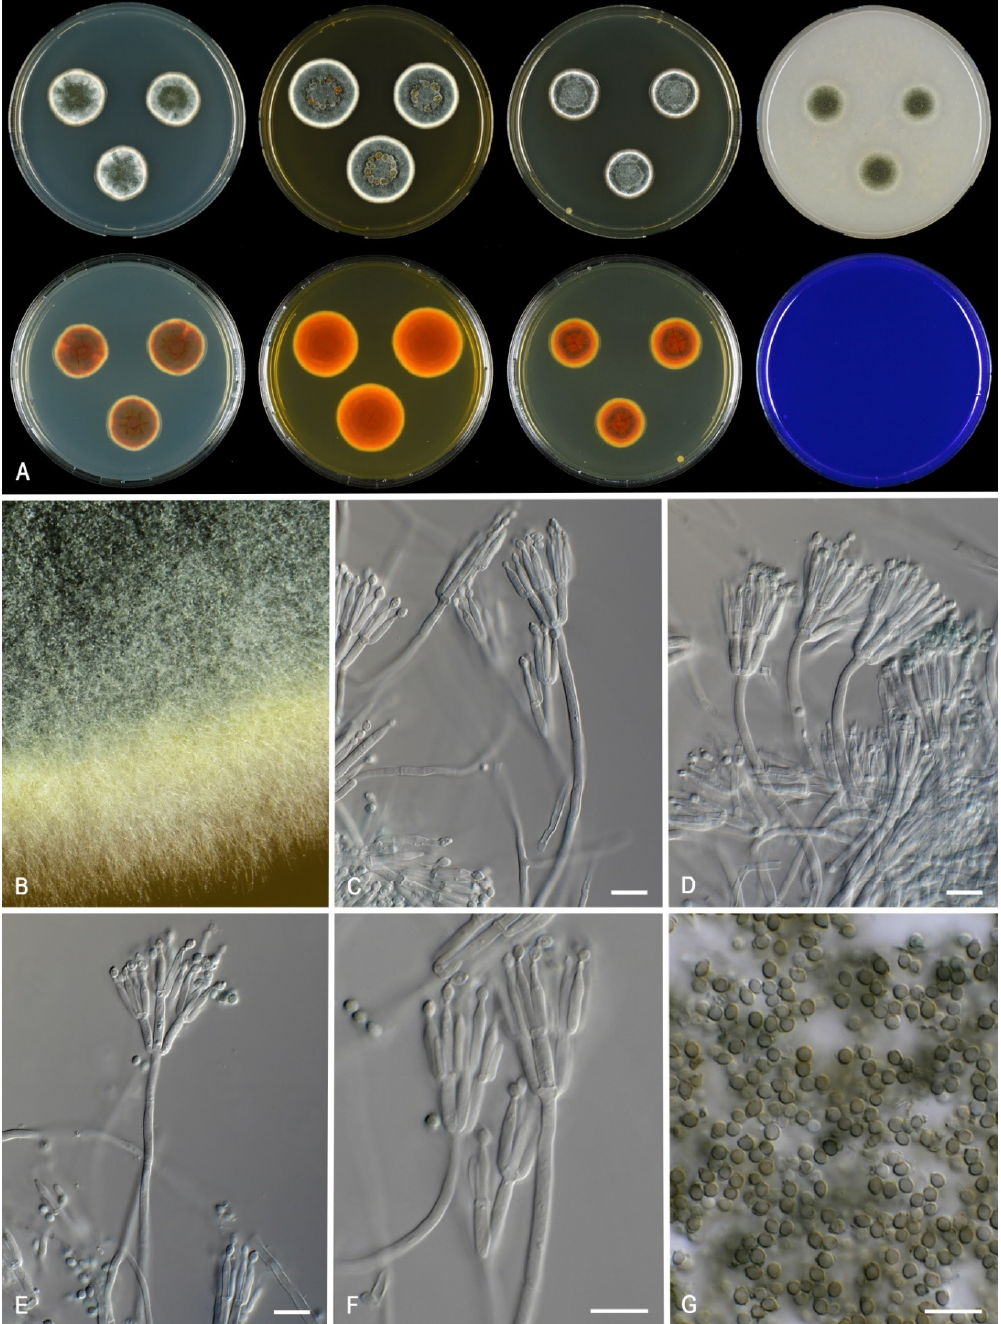
Figure 5. Morphological characters of Talaromyces africanus (CBS 147340). ( A ). Colonies, from left to right, after 7 d at 25 °C (top row) CYA, MEA, YES, OA; (bottom row) CYA reverse, MEA reverse, YES reverse, CREA. ( B ). Detail of colony on MEA. ( C – F ). Conidiophores and conidia. ( G ). Conidia. Scale bars = 10 μ m.